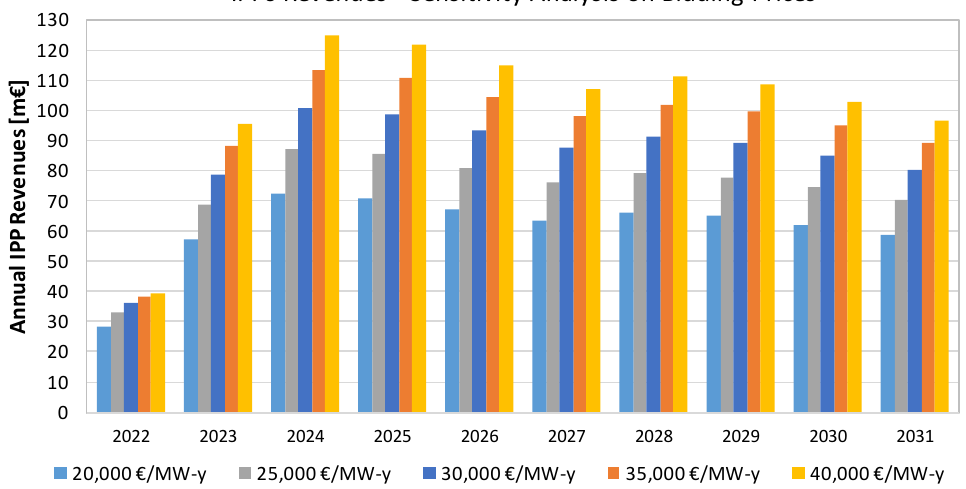
Figure 7. IPP revenues sensitivity analysis–Base strategy.